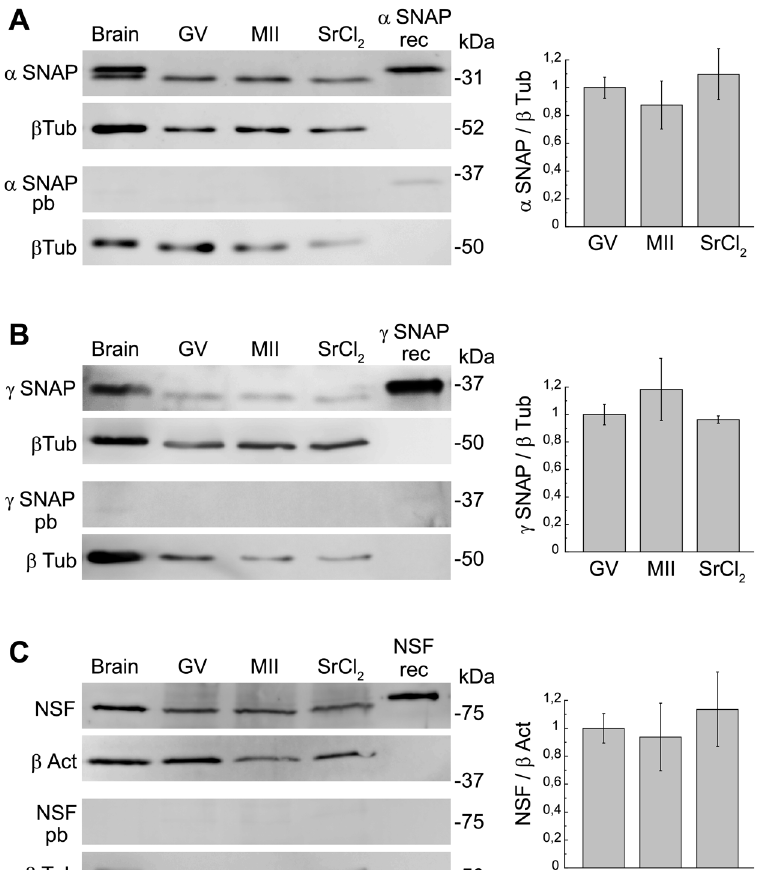
Fig 2. Detection of α -SNAP, γ -SNAP and NSF by Western blot. A . Left , Upper panels : Inmunoblot of α - SNAP: Protein extracts from equal numbers (150) of GV-intact oocytes (GV), MII oocytes (MII) and parthenogenetic activated MII oocytes with 10mM strontium chloride (SrCl 2 ) were separated on a 12% SDS-PAGE gel. Positive controls: mouse brain (Brain, 1.25 μ g) and recombinant His6- α -SNAP ( α SNAP rec, 5 ng). Immunoblot of β - tubulin ( β Tub) was performed as a control of protein loading. Lower panels : Immunoblot using anti- α -SNAP antibody preabsorbed with full lenght α -SNAP recombinant protein ( α SNAP pb). Right , densitometry analysis of Western blots for α -SNAP (mean ± SEM, n = 4) showing α -SNAP protein expression level ( α SNAP/ β Tub ratio) relative to GV expression, set as 1. B . Left , Upper panels : Inmunoblot of γ -SNAP: Protein extracts from equal numbers (300) of GV-intact oocytes (GV), MII oocytes (MII) and parthenogenetic activated MII oocytes with 10mM strontium chloride (SrCl 2 ) were separated on a 12% SDS-PAGE gel. Positive controls: mouse brain (Brain, 6 μ g) and recombinant thrombine cleaved γ - SNAP-GST ( γ SNAP rec, 0.2 μ g). Immunoblot of β - tubulin ( β Tub) was performed as a control of protein loading. Lower panels : Immunoblot using anti- γ -SNAP antibody preabsorbed with γ -SNAP control peptide ( γ SNAP pb). Right , densitometry analysis of Western blots for γ -SNAP (mean ± SEM, n = 3) showing γ -SNAP protein expression level ( γ SNAP/ β Tub ratio) relative to GV expression, set as 1. C . Left , Upper panels : Inmunoblot of NSF: Protein extracts from equal numbers (200) of GV-intact oocytes (GV), MII oocytes (MII) and parthenogenetic activated MII oocytes with 10 mM strontium chloride (SrCl 2 ) were separated on a 15% SDS-PAGE gel. Positive controls: mouse brain (Brain, 3,5 μ g) and recombinant His6-NSF (NSF rec, 75 ng). Immunoblot of β - actin ( β Act) was performed as a control of protein loading. Lower panels : Immunoblot using anti-NSF antibody preabsorbed with NSF control peptide (NSF pb). Right , densitometry analysis of Western blots for NSF (mean ± SEM, n = 3) showing NSF protein expression level (NSF/ β Act ratio) relative to GV expression, set as 1. In all panels MW protein standards (x10 3 ) are indicated on the right and primary antibodies, on the left.